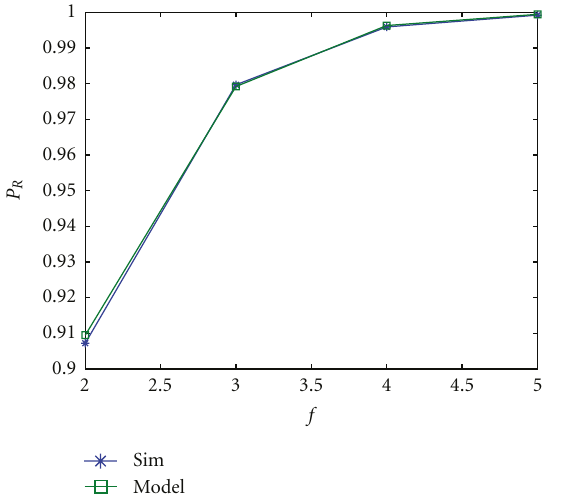
Figure 8: Analytical and simulation results of P R versus f when P = 0.01 and r = 10m.